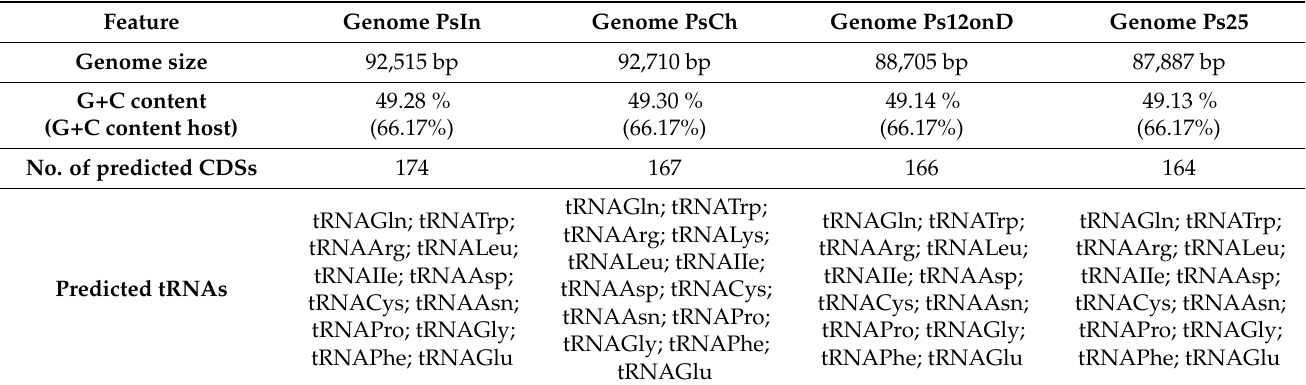
Table 1. General features of PsIn, PsCh, Ps12on-D, and Ps25 phage